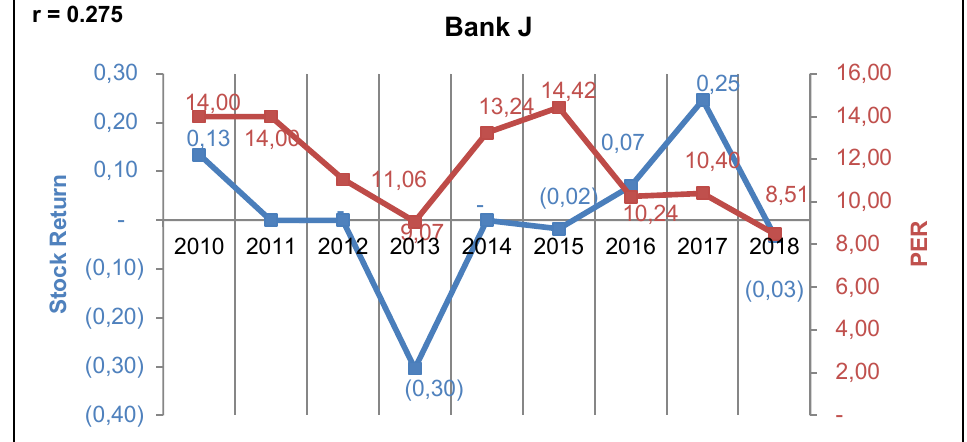
Figure 9: For Bank J